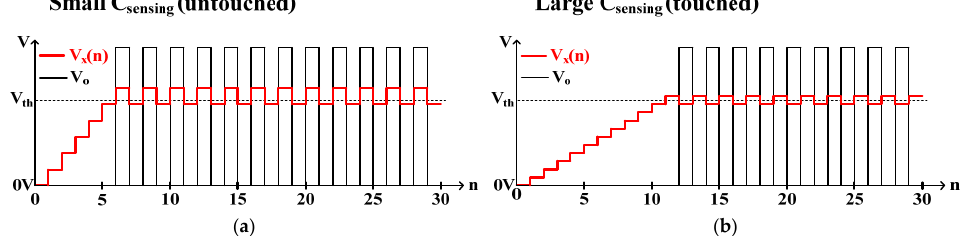
Figure 3. Sensing mechanism of the capacitance readout circuit for: ( a ) an untouched case; ( b ) a touched